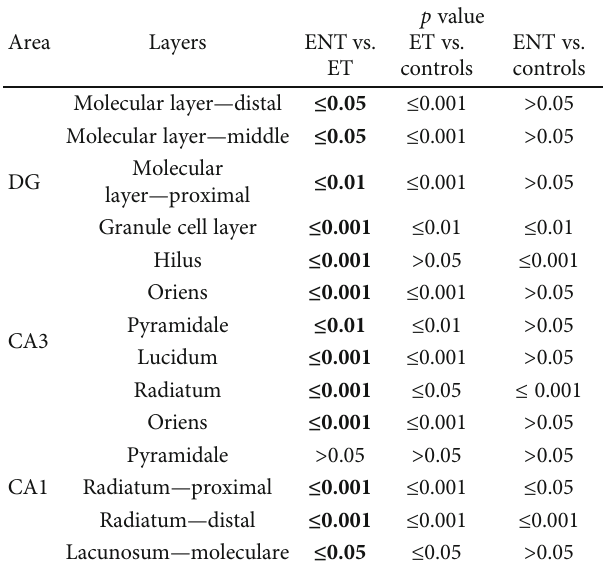
Table 4: Animals with tinnitus and animals without tinnitus exhibited di ff erent VGAT labeling in most layers, analyzed with two-way ANOVA followed by Tukey-Kramer post hoc correction for multiple